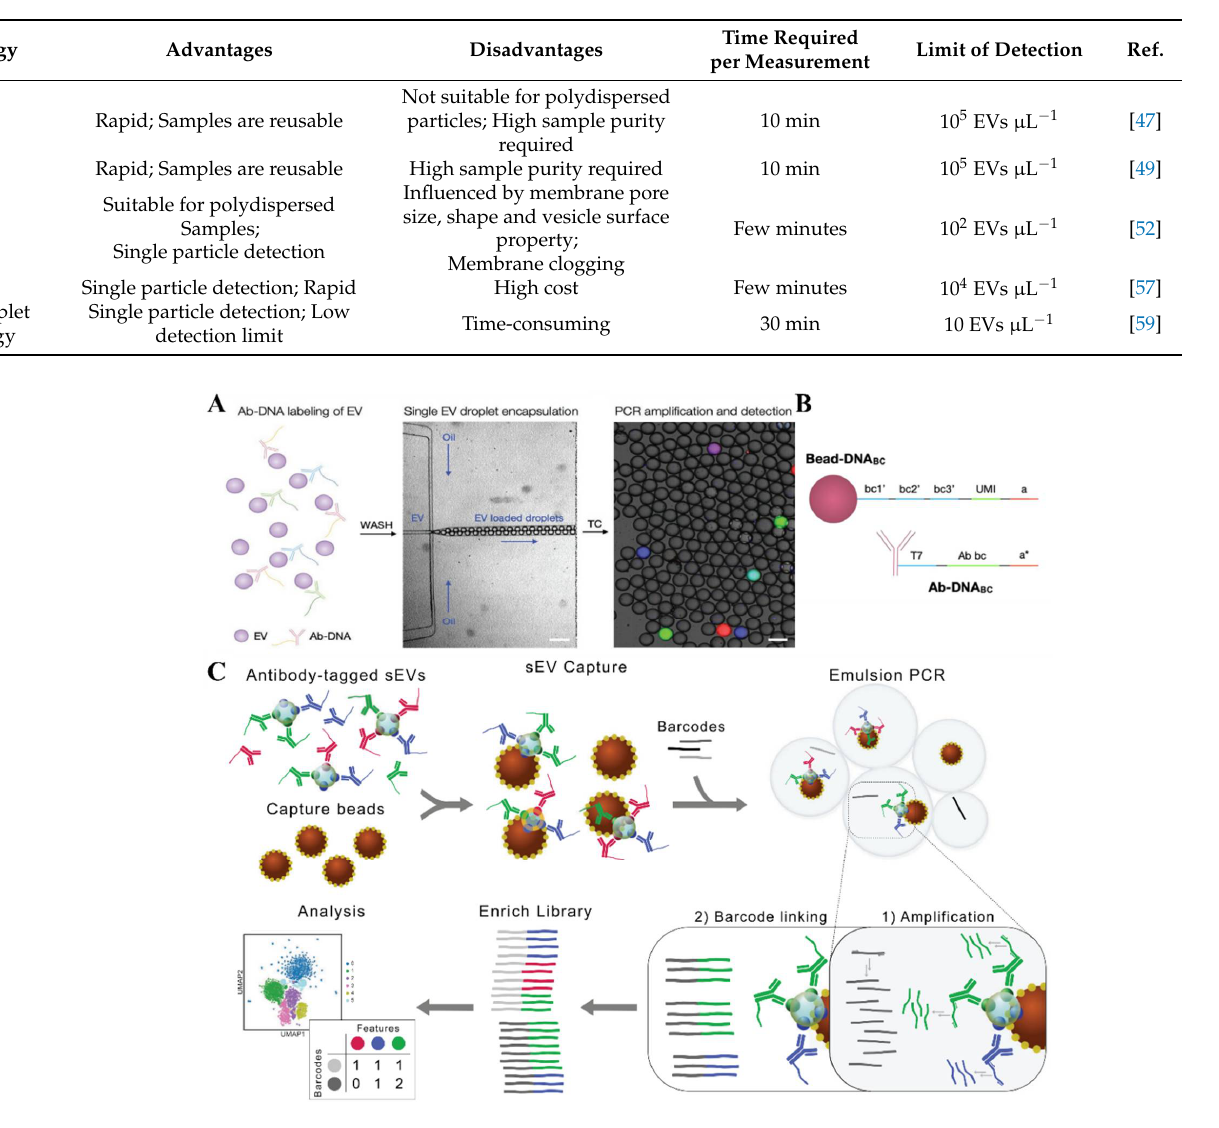
Table 1. Comparison of the different vesicle analysis techniques.